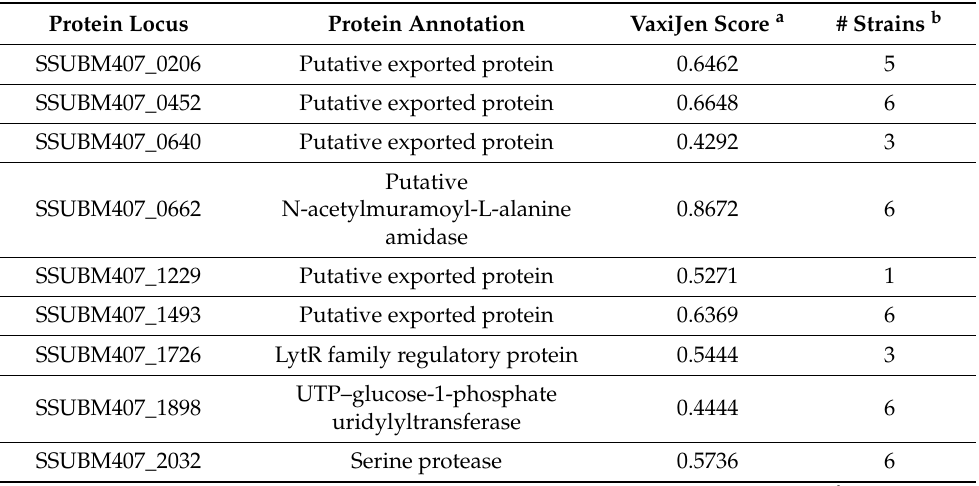
Table 2. Predicted antigenicity of identified type-I signal peptide secreted proteins. Protein